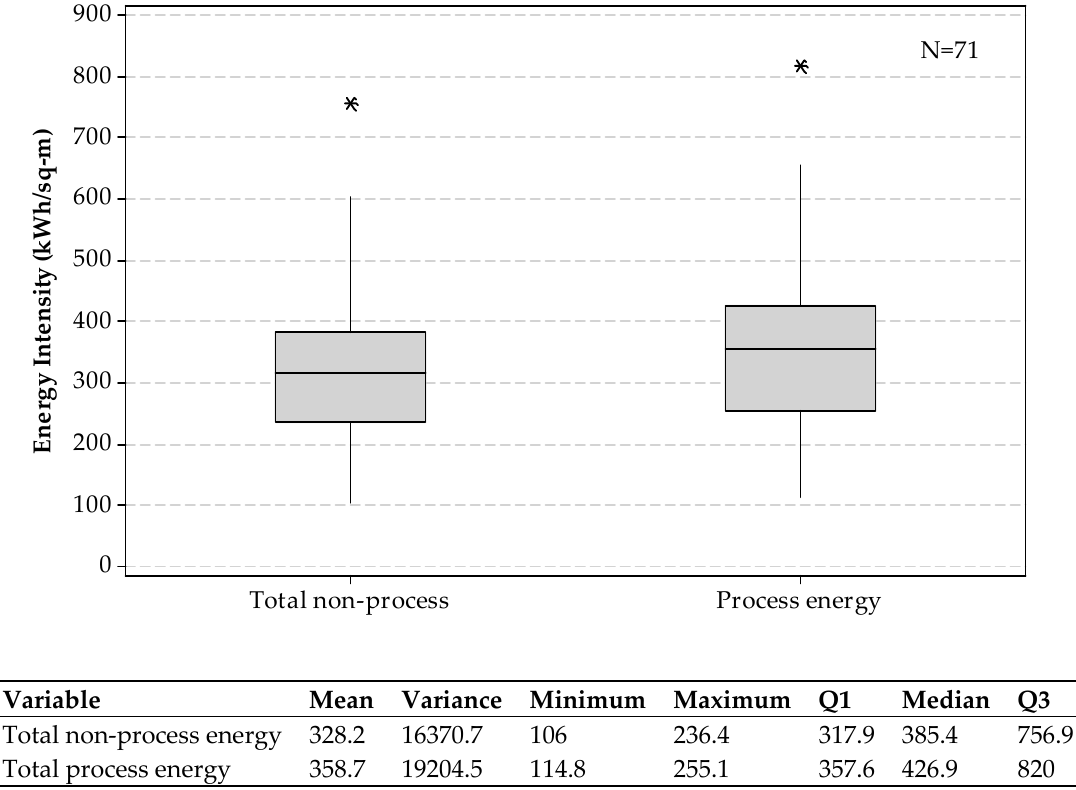
Figure 9. Process and non-process annual energy intensity (kWh/m 2 ) comparison. Notes: * represents